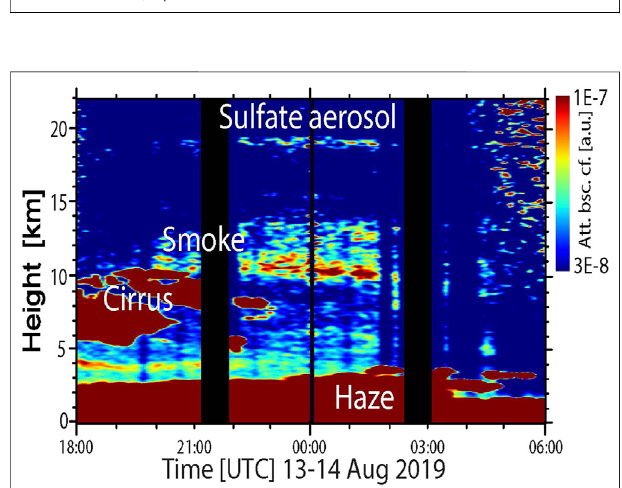
FIGURE 6 | HYSPLIT 13-days backward trajectories (Stein et al., 2015; Rolph et al., 2017) for August 14, 2019, 1:00 UTC, arriving at 10 km (red), 12 km (blue) and 14 km height (green) above Leipzig (indicated by a star at 51.3 ° N, 12.4 ° E). The CALIPSO fl ight track of the measurements shown in Figure 5 is indicated by a straight line from northern Scandinavia to the Balearic Islands, Spain.